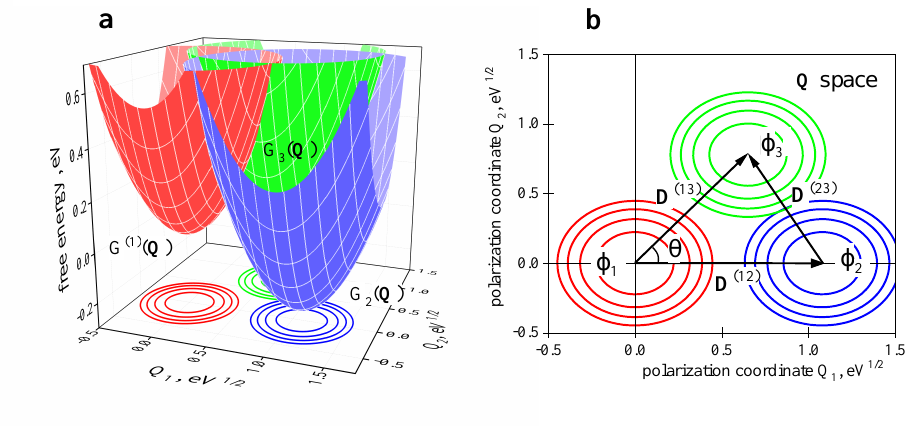
Figure 3. ( a ) Free energy surfaces of the ET states | ϕ 1 (cid:105) = D ∗ A 1 A 2 , | ϕ 2 (cid:105) = D + A − − | ϕ (cid:105) = D + A as functions of the polarization coordinates. These curves are constructed by 3 1 A 2 projection of the 4-dimensional G ( n ) ( q ) surfaces into the 2-dimensional Q subspace. The values of the model parameters are indicated in the text. ( b ) FESs minima on the ( Q 1 , Q 2 ) plane. The displacement vectors D ( nn (cid:48) ) and the θ angle are also